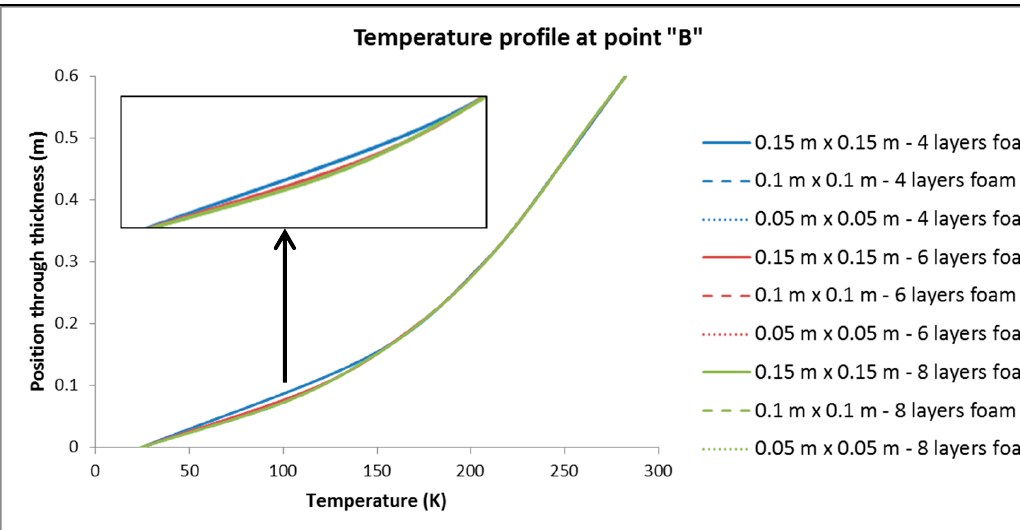
Figure 7. Temperature profile through the insulation thickness at point “B” of Figure 5.